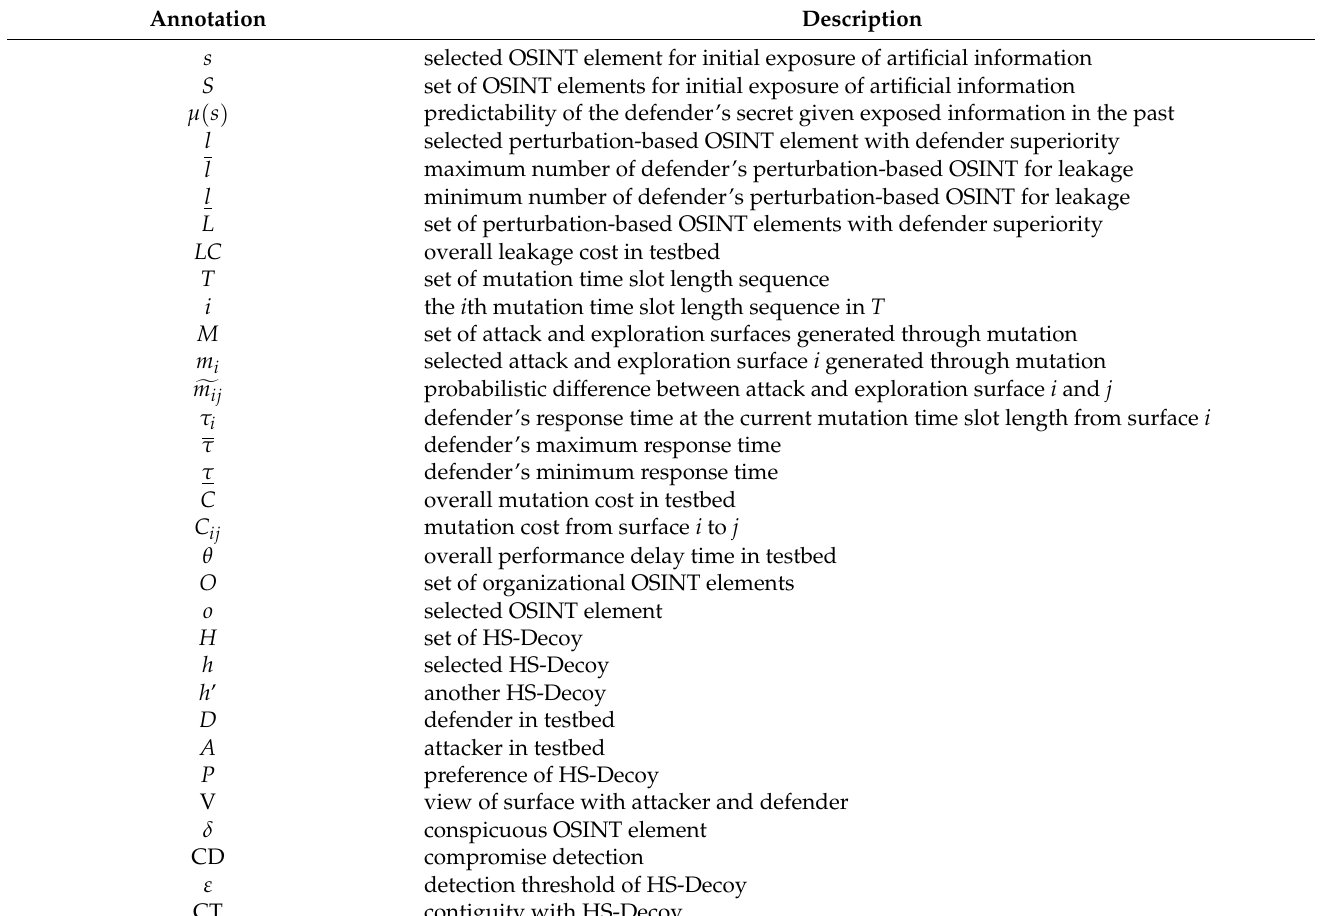
Table A7. List of annotations for LPC-MTD and HS-Decoy equations in this paper. Annotation